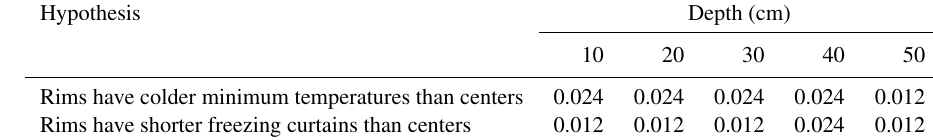
Table 4. Rank sum test results ( p -values) for two hypotheses. Hypothesis